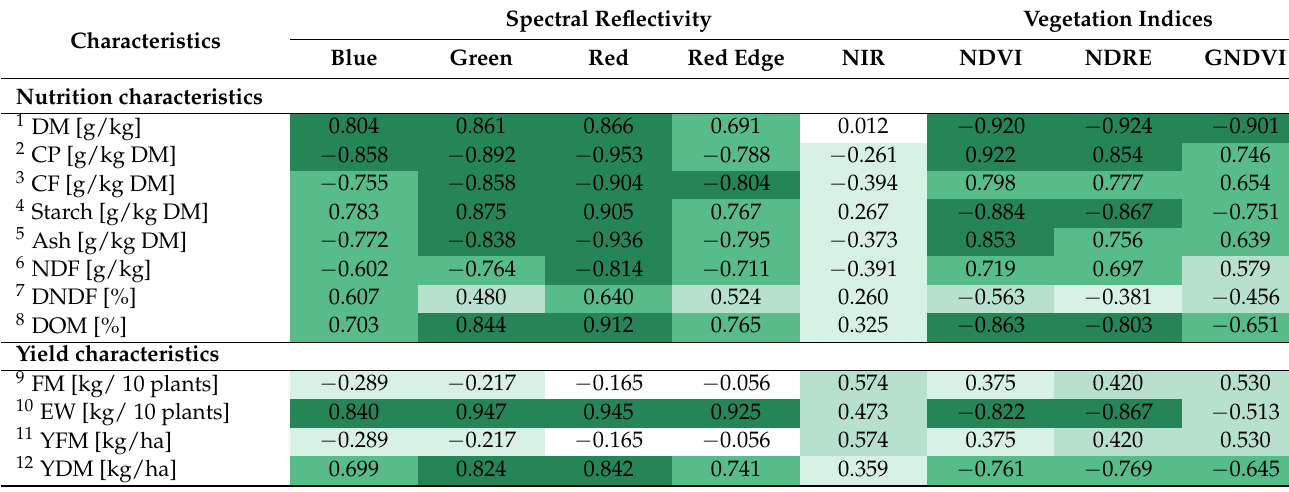
Table 5. The correlation coefficients relevant for the data acquired through multispectral imaging and by means of the chemical